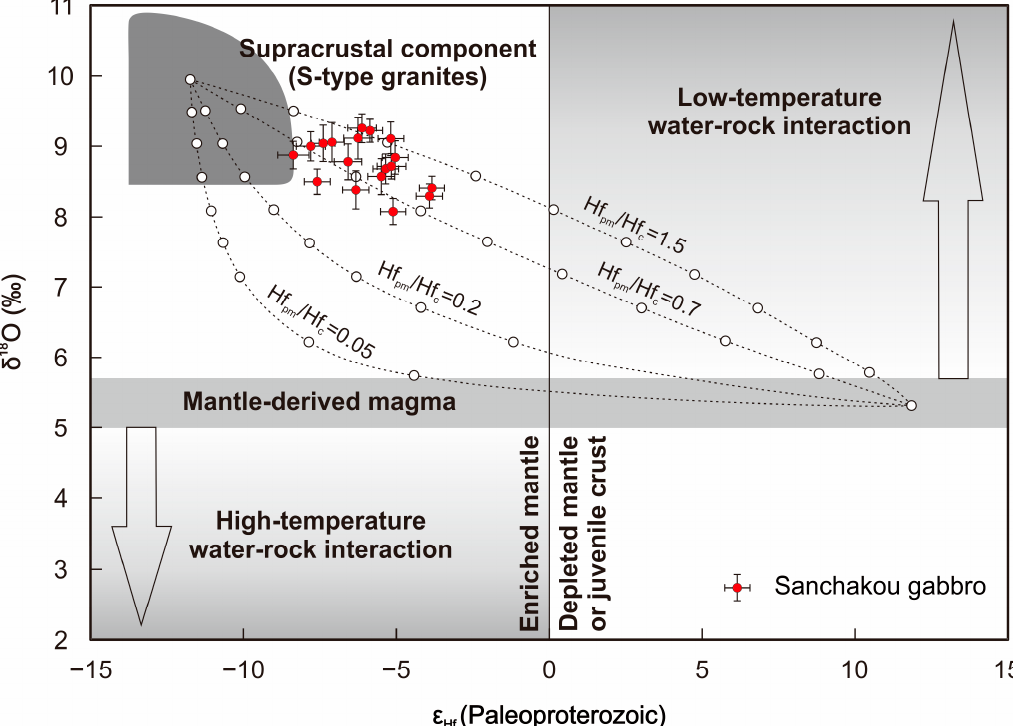
Figure 9. The zircon δ 18 O versus ε Hf (t) diagram of the Sanchakou gabbros. The dotted lines indicate